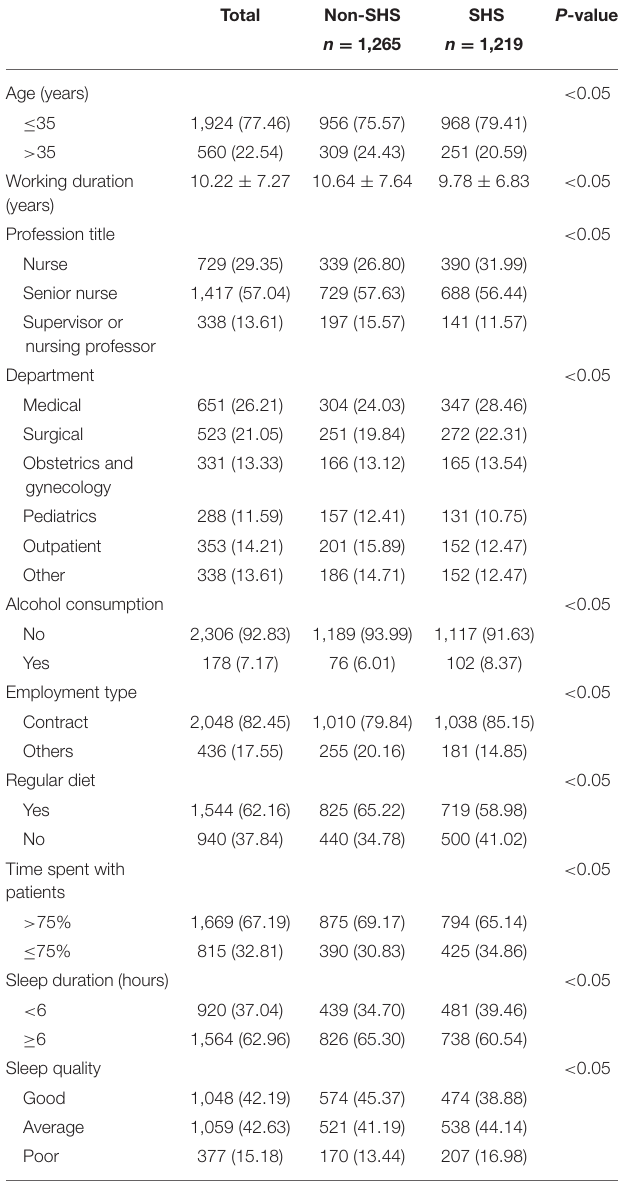
TABLE 1 | Participant characteristics according to exposure to SHS ( n =